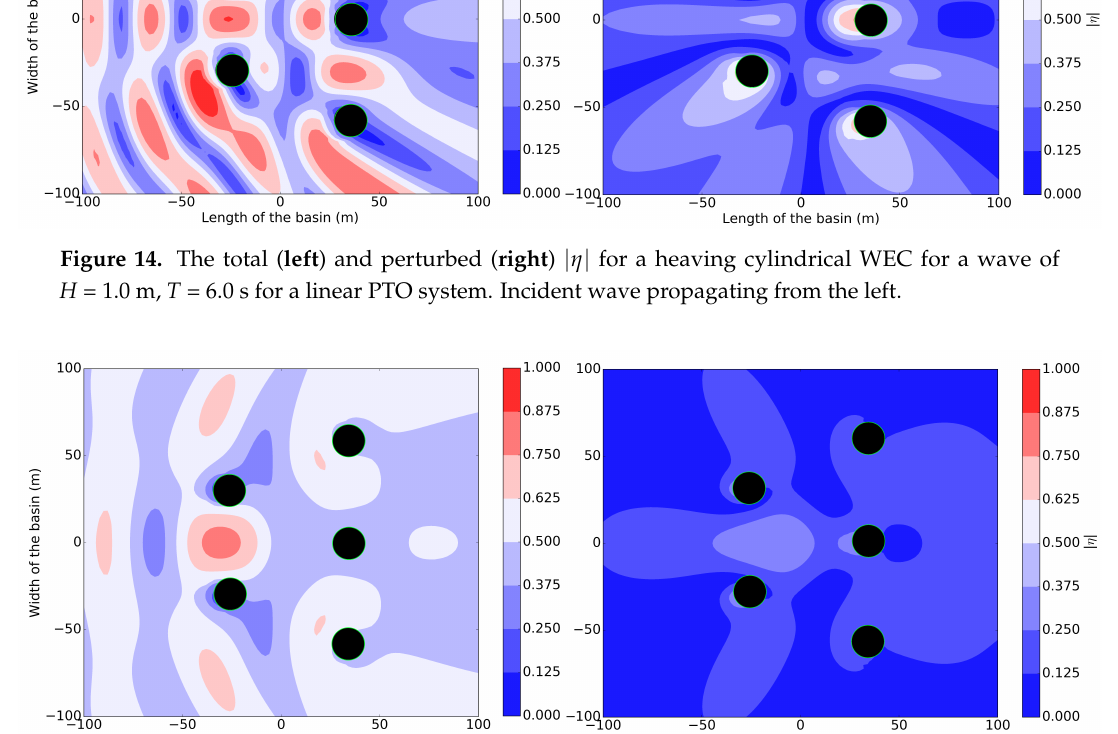
Moving on to the two higher wave periods, T = 10.0 s and T = 12.0 s, the interaction of the incident wave field with the WEC array markedly decreases. We can observe this in a contour plot of the total and the perturbed wave field for T = 10.0 s for the heaving cylindrical WEC array with a linear PTO system in Figure 16. We note that although the perturbed wave field is barely perceptible, it does result in a slight enhancement of the total wave field which creates an area of higher total | η | in front of the array. For T = 12.0 s the shape of the interaction zones is similar to those of T = 10.0 s but the magnitude of the array effects is minimal and consequently, these wave fields are not displayed in the interest of